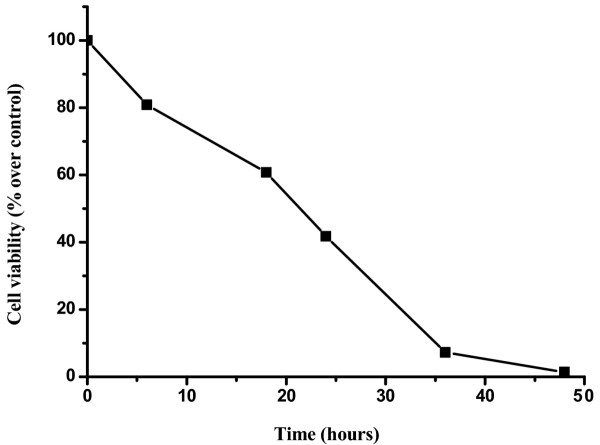
Bis-aziridinylnapthoquinone (AZ-1) inhibited the proliferation of cell line BC-M1. Shown is the cell viability of BC-M1 cells at various times using the IC50 dose (0.51 μM) of AZ-1 challenge. The MTT assay was used to determine the cell viability. Data are from quadruplet wells and are representative of three separate experiments.